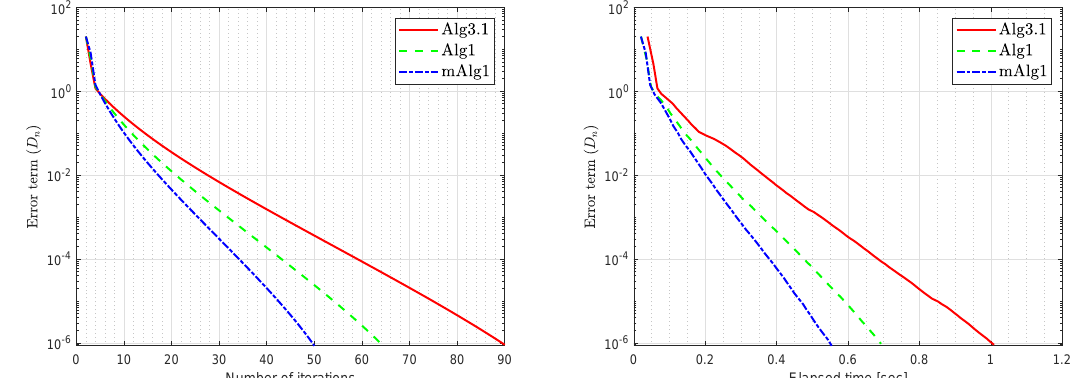
Figure 9. Example 4: Algorithm 1 (mAlg1) numerical comparison with Algorithm 3.1 (Alg3.1) in [39] and Algorithm 1 (Alg1) in [38] while m = 20.